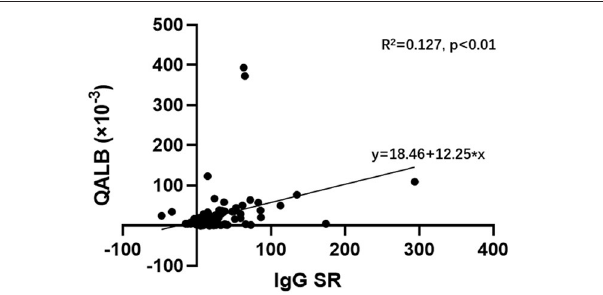
FIGURE 4 | Linear regression analysis of the IgG SR and QALB in the GBS and CIDP groups. Linear regression analysis showed a linear correlation between the IgG SR and QALB (R 2 = 0.127, P < 0.01) in the GBS and CIDP